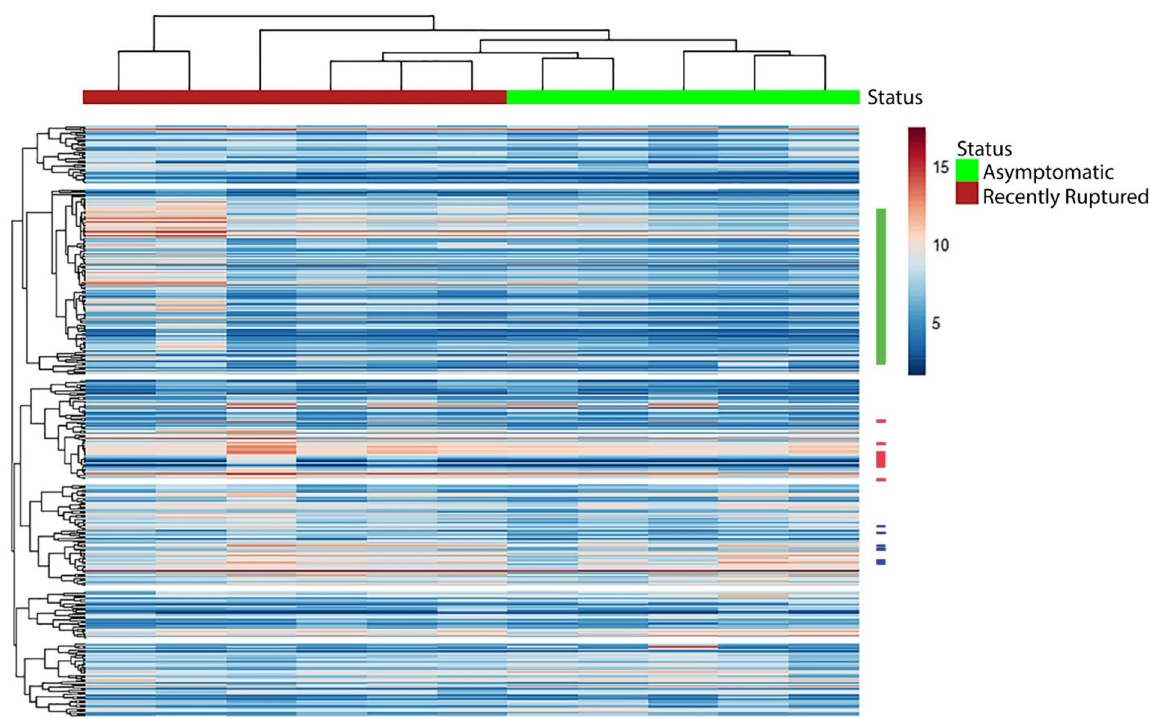
Figure 2. Hierarchical clustering identifies groups of co-expressed transcripts that distinguish recently ruptured plaques from asymptomatic plaques. Clustering of the top 400 transcripts in carotid plaques differentiates between asymptomatic and recently ruptured plaques. Bars adjacent to the cluster indicate locations of transcripts associated with B cell function (green), metalloproteinases (blue), and interferon responses (red). Supplementary Fig. 2 presents this data with the transcript names included.